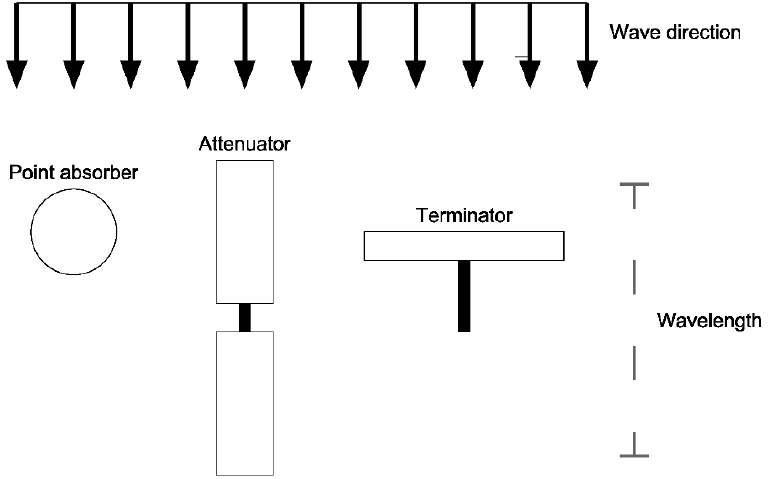
Figure 6. Global wave power GIS map.